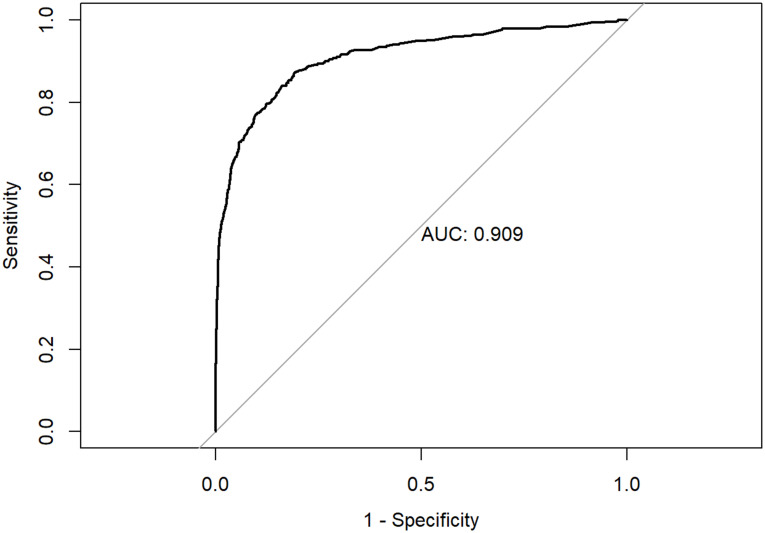
Area under the curve (AUC) for logistic model fit to predict RT-PCR status given symptoms or patient demographics.